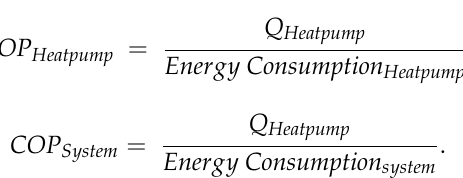
Figure 17. Comparison of system COP according to the optimization results by building type.